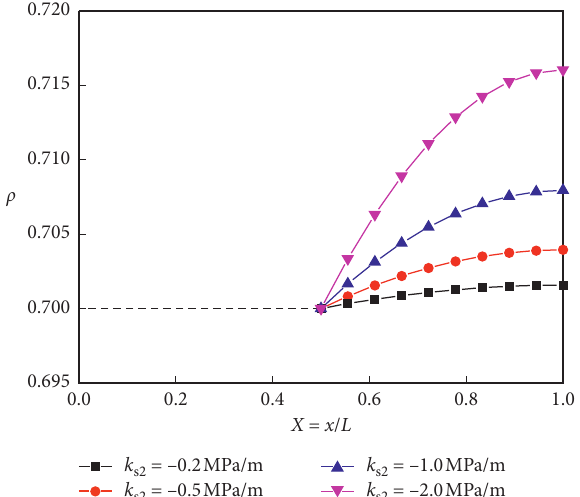
Figure 25: Effect of the interface frictional resistance at stage IV on k s 2 .